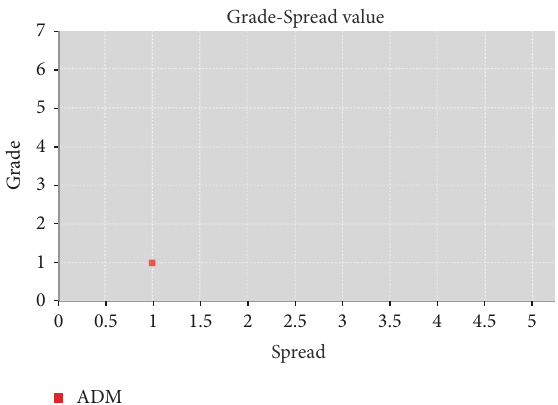
Figure 12: Grade-Spread value obtained by FSV applied to MCS FST#2peaks results [20] and its approximation by 2P- AEF(2,1,2) using GA for parameters